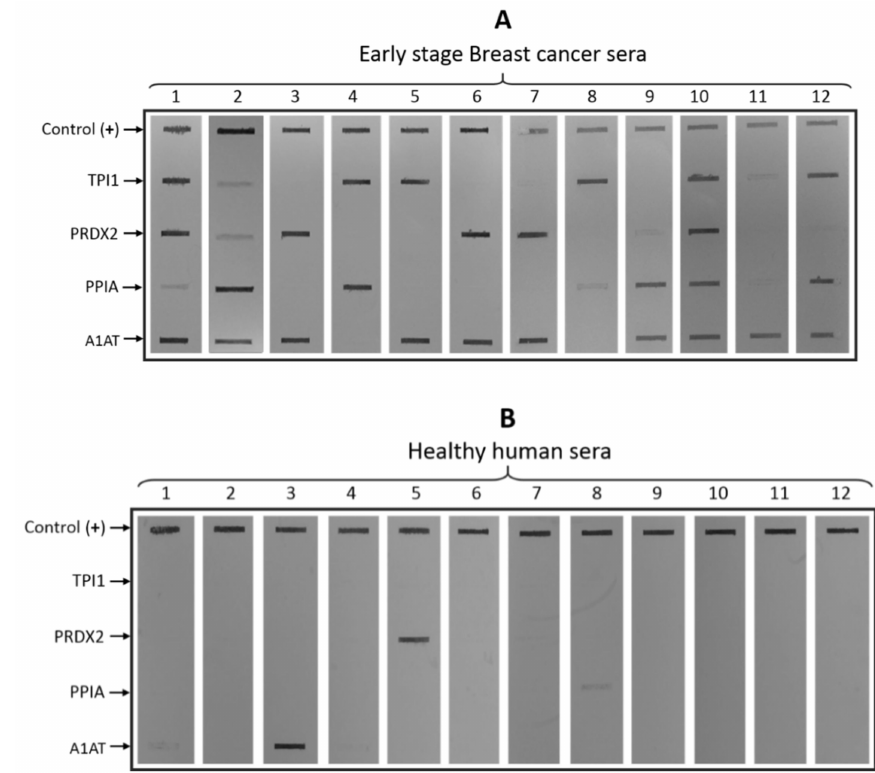
Figure 2. Dot-blot analysis for serum reactivity. ( A ) Early-stage breast cancer sera (lanes 1–12); top line, control lane (human IgG). The TPI1, PRDX2, PPIA, and A1AT, lanes 1–12, the patients’ sera. ( B ) Healthy human sera; top line, control lane (human IgG). TPI1, PRDX2, PPIA, and A1AT; lanes 1–12, healthy persons’